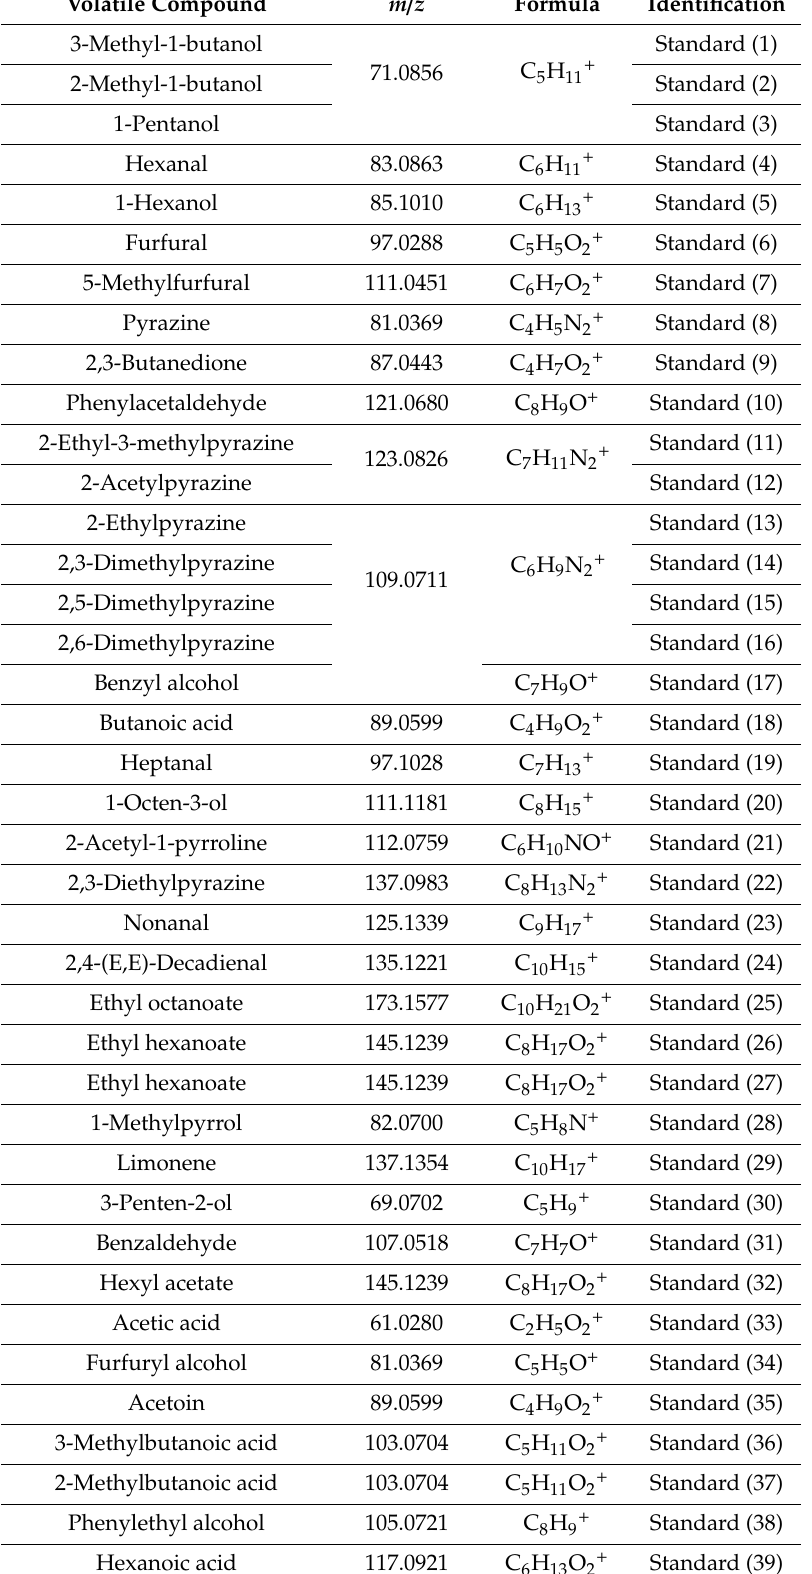
Table 1. 54 volatile compounds selected as important contributors to bread aroma, including their m / z and formula. Thirty-nine volatile compounds were confirmed by means of fast GC-proton transfer reaction-time of flight-mass spectrometry (PTR-ToF-MS) using pure standards, while the other 15 were tentatively identified based on their m / z , possible formula, and literature about bread